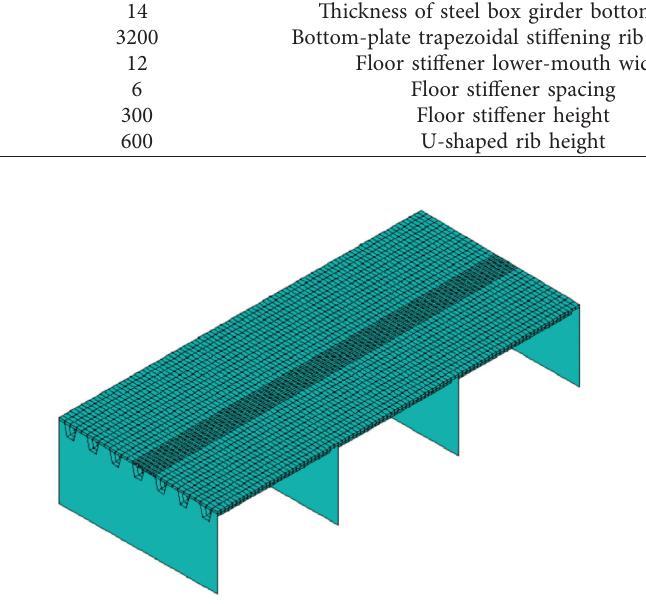
Figure 9: The orthotropic bridge model.